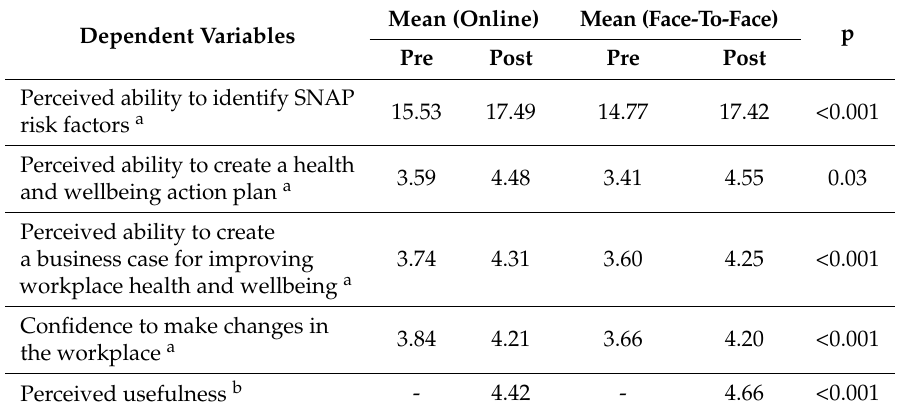
Table 1. Pre and/or post training scores for online and face-to-face training modes of training among Western Australian employees engaging in the training program between June 2016 and April